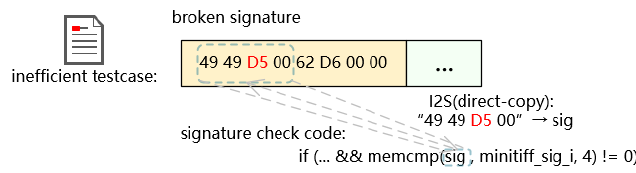
Figure 3. Example of an I2S